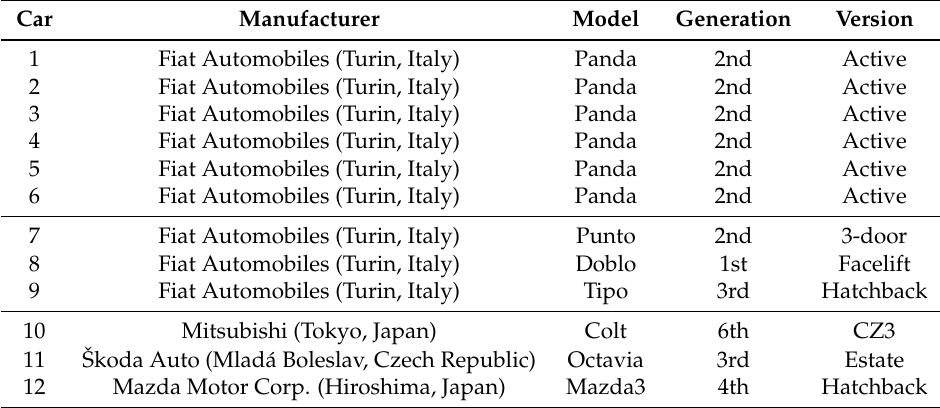
Table 1. Order and specifications(brand and model) of the cars used in the data collection.